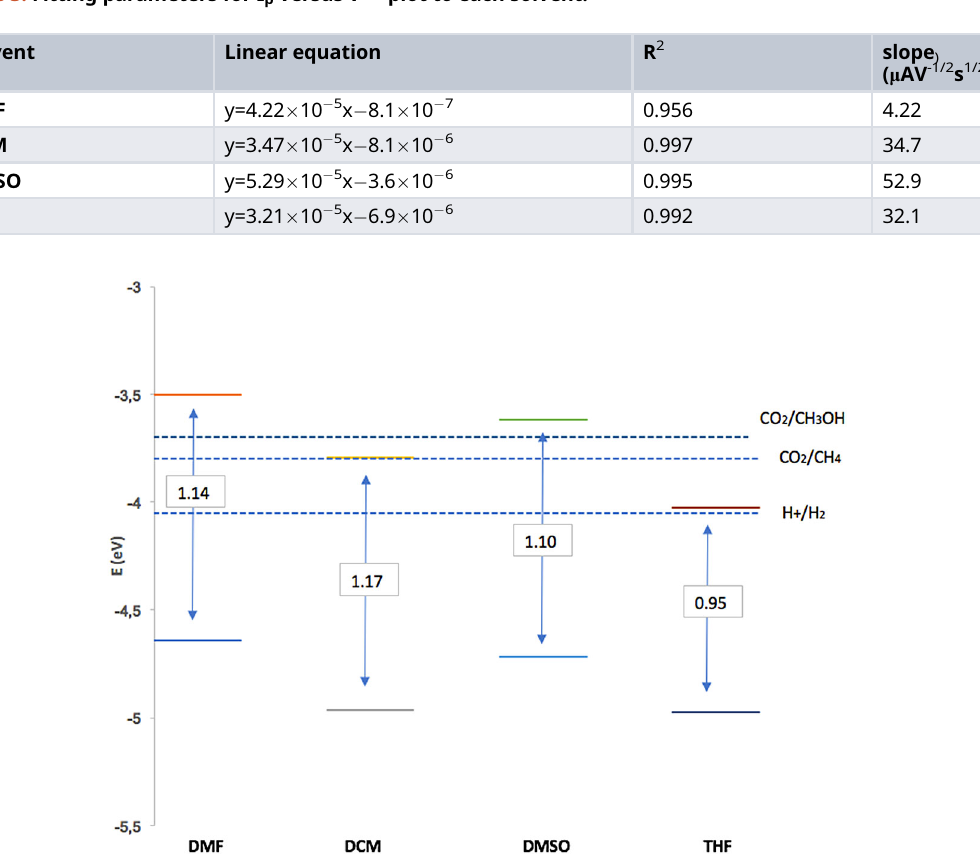
Figure 7. Band gap and band edge positions to Sn-Porphyrin derivative for dissolvent used in this work. Y-axis energy levels for the reduction and oxidation potentials of the dissociation reactions. pH = 7 y room